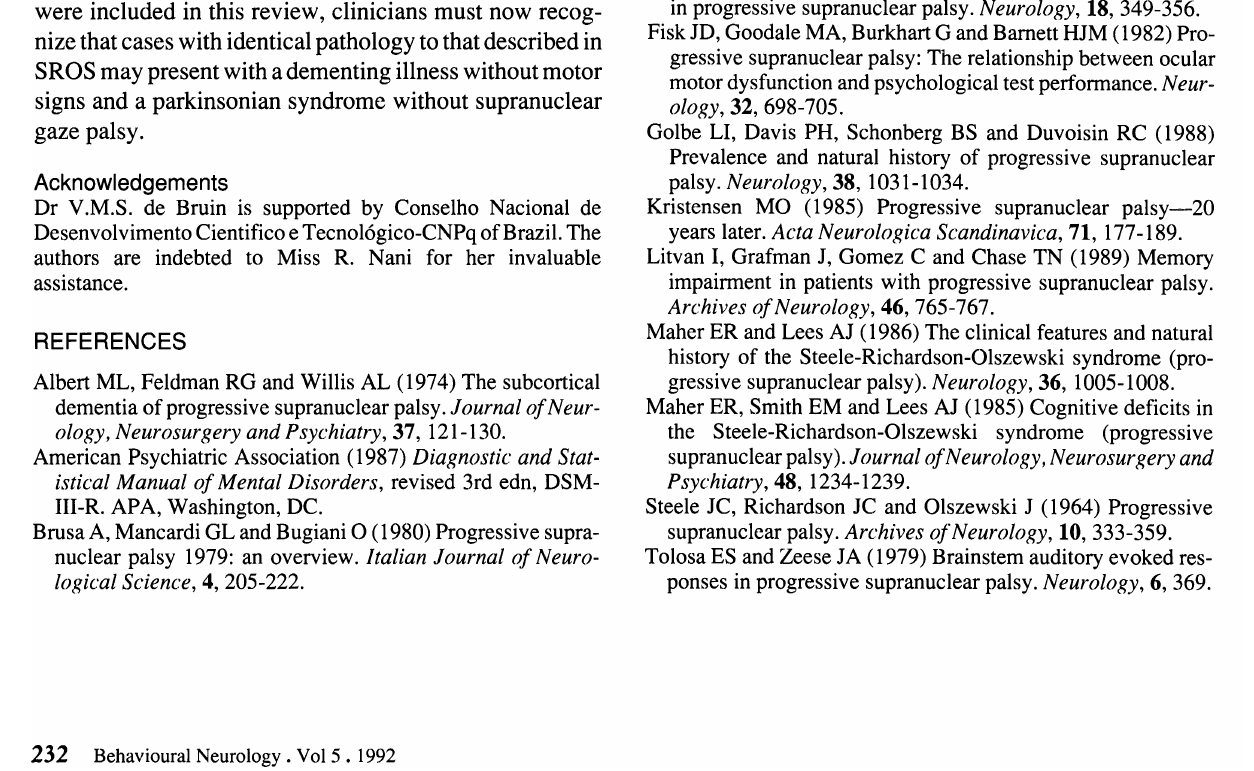
Although only patients with classical features of